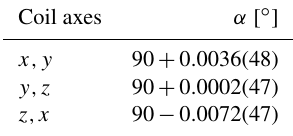
Table 2. Coil constants obtained for each axis ( x,y,z ) including uncertainties according to BIPM et al. (2008) on a confidence level of 95% (last two digits).